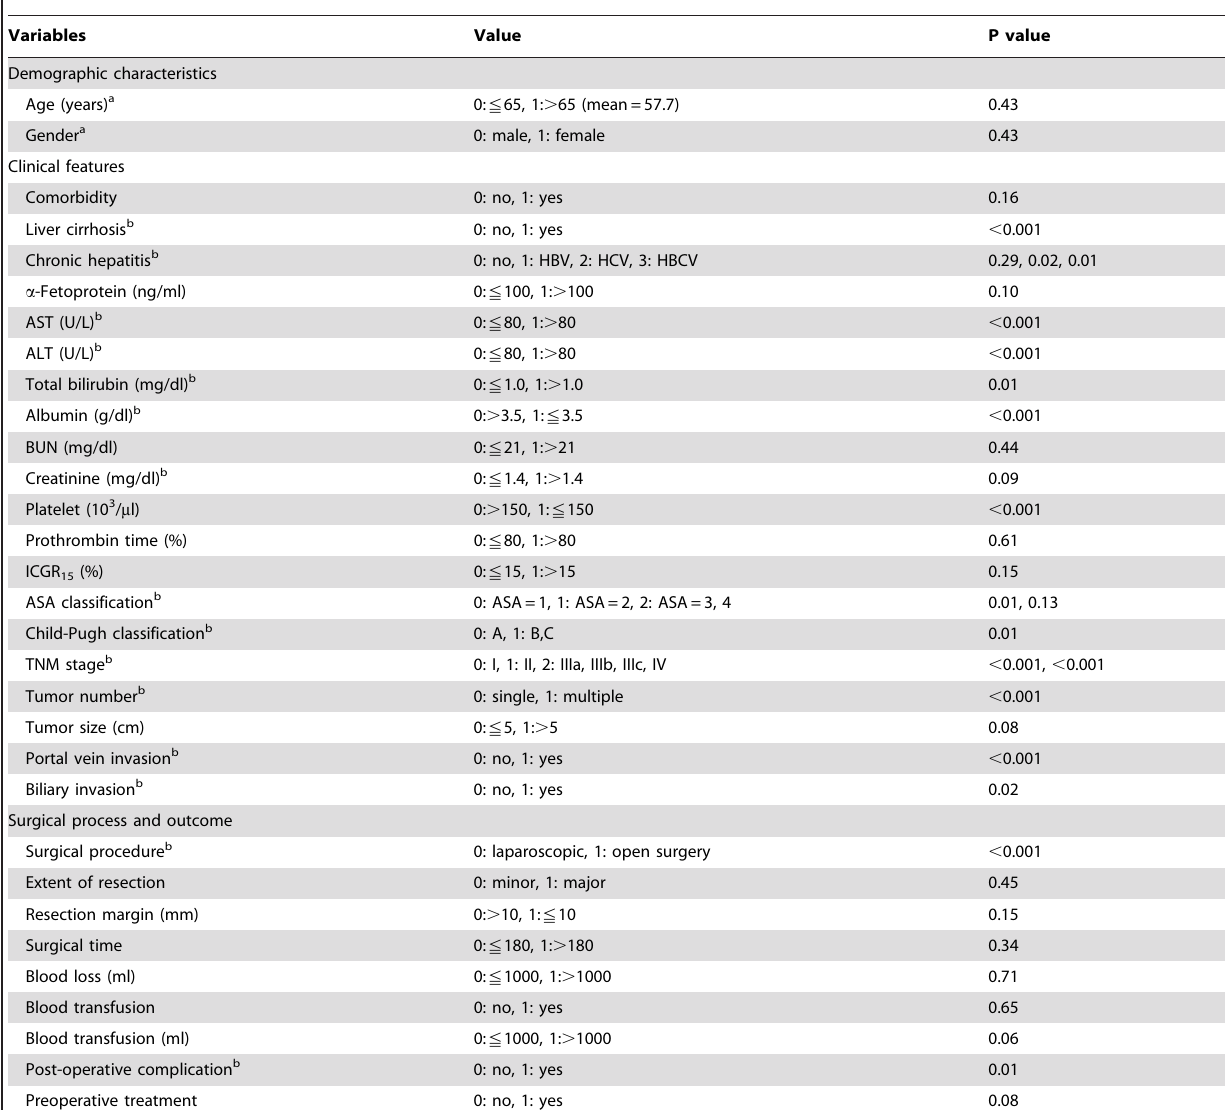
Table 1. Potential input variables for prediction models (N